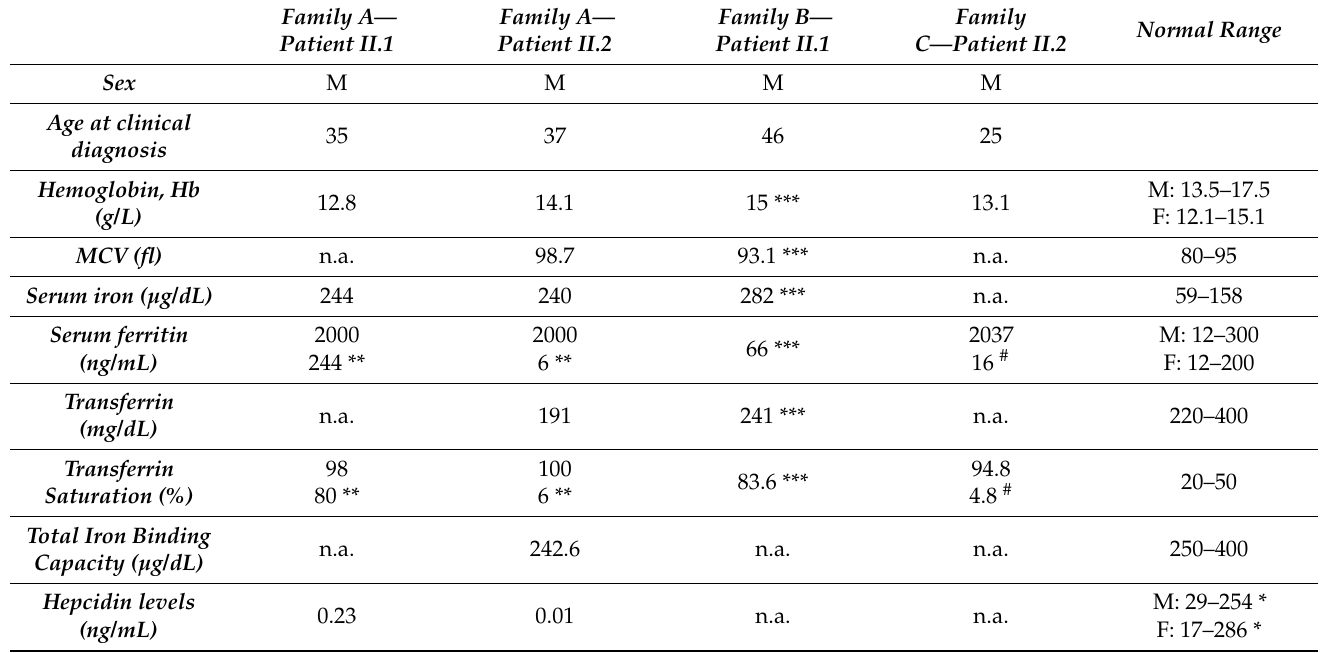
Table 2. Clinical, biochemical, and genetic data of patients affected of autosomal recessive non-HFE related HH due to TFR2 mutations. F, Female. M, Male. (a) Data from January 2019. (b) Data from January 2018. (c) Data from November 2018. (d) Data from May 2019. n.a., not available. * Adult serum hepcidin reference values according to (Ganz et al., 2008) are: mean of 121 ng/mL (5–95% CI: 29–254 ng/mL) for men and mean of 87 ng/mL (5–95% CI: 17–286 ng/mL) for women. #